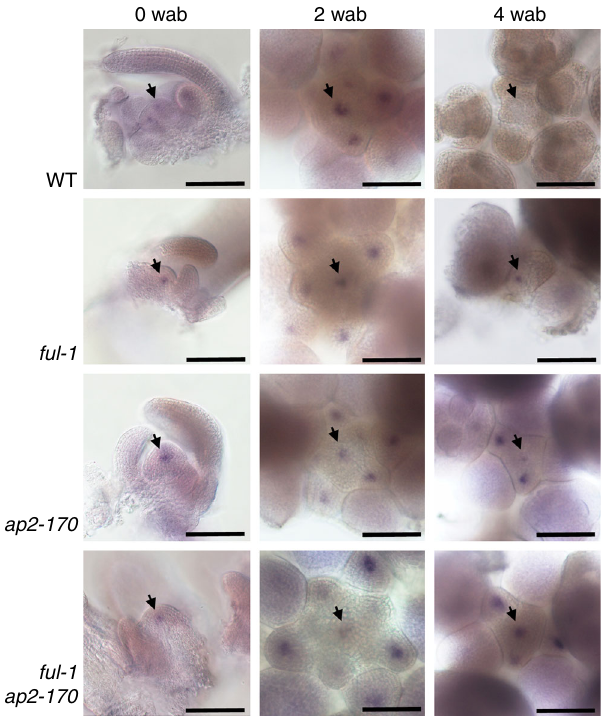
Fig. 2 WUS expression is temporally extended in the SAM of ful and ap2- 170 mutants. Whole mount in situ hybridization of WUS mRNA in SAMs from different genetic backgrounds shortly after fl oral transition (0 weeks after bolting- 0 wab), 2 weeks after bolting (2 wab) and 4 weeks after bolting (4 wab), a time point when wild-type plants have undergone GPA and stop producing new fl oral meristems, while mutants are still proliferative. Arrows indicate the SAM. Bars = 100 µ